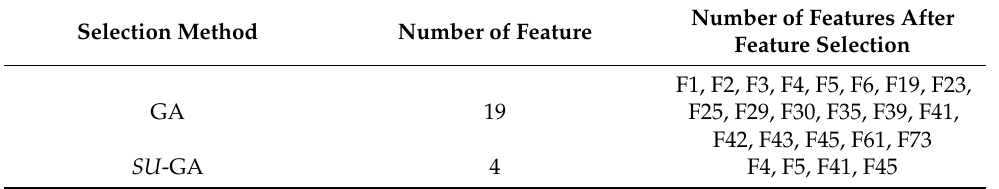
Figure 12. The convergence curve of SU-GA and GA. Table 3. Feature selected by GA and SU